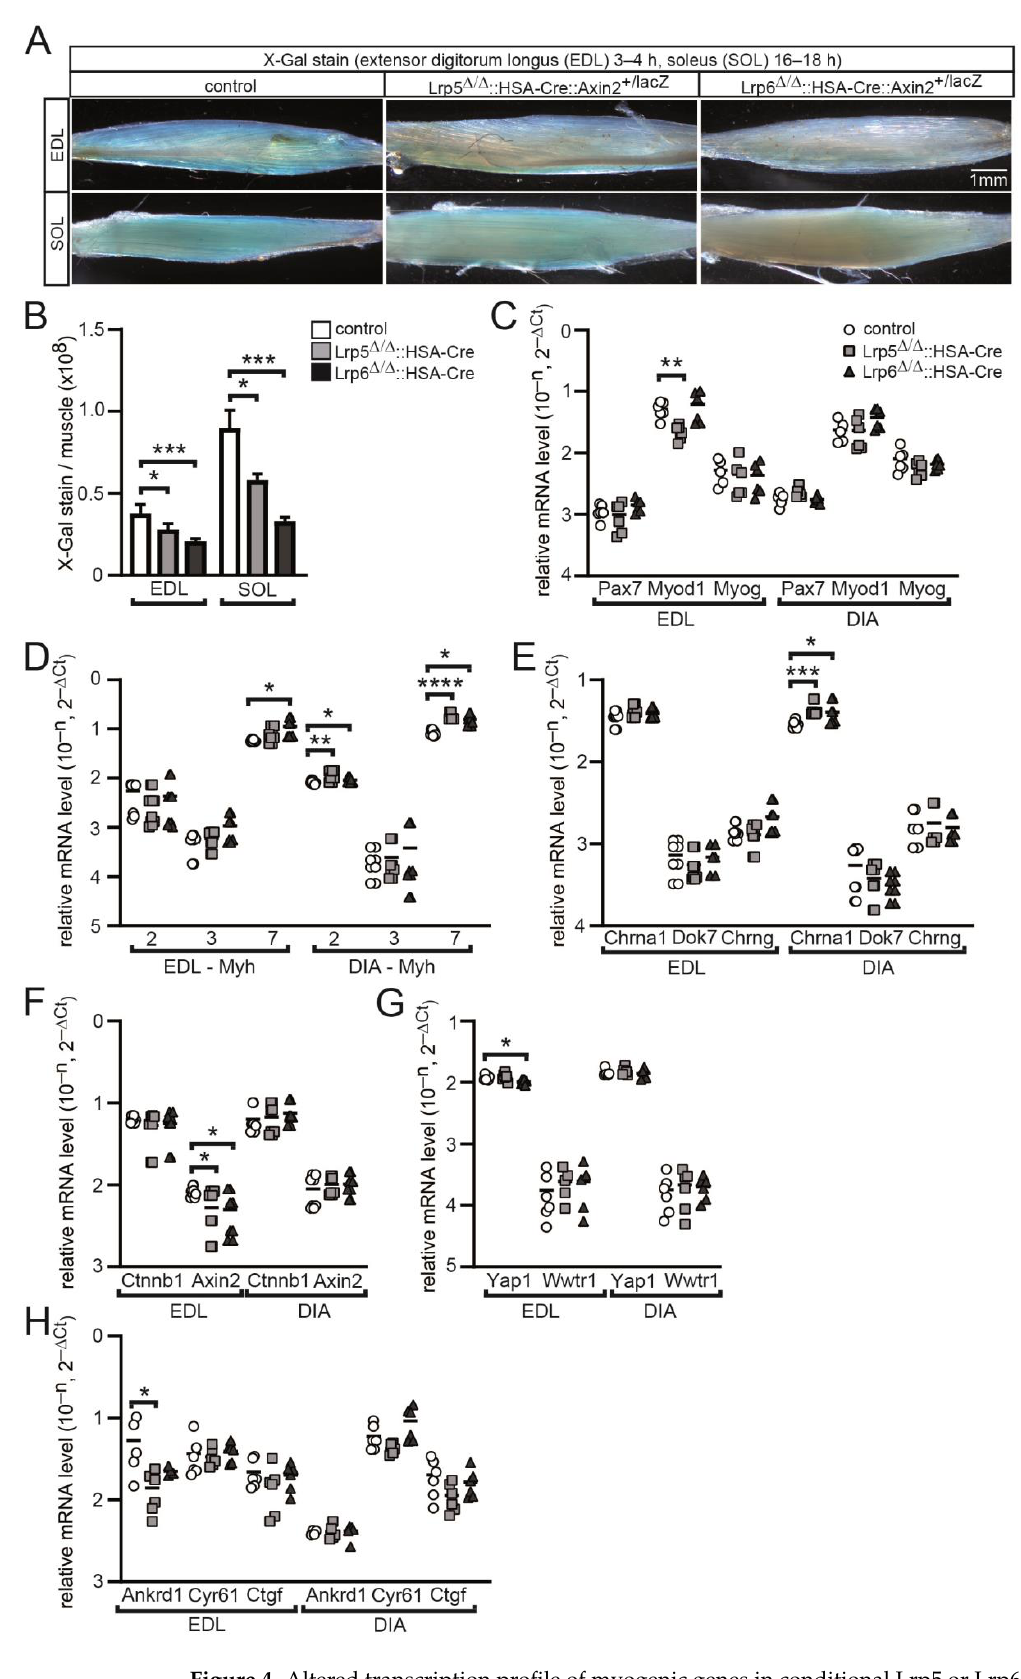
Figure 4. Altered transcription profile of myogenic genes in conditional Lrp5 or Lrp6 knockout mice. ( A ) Extensor digitorum longus (EDL) and soleus (SOL) muscles of control and different mutant